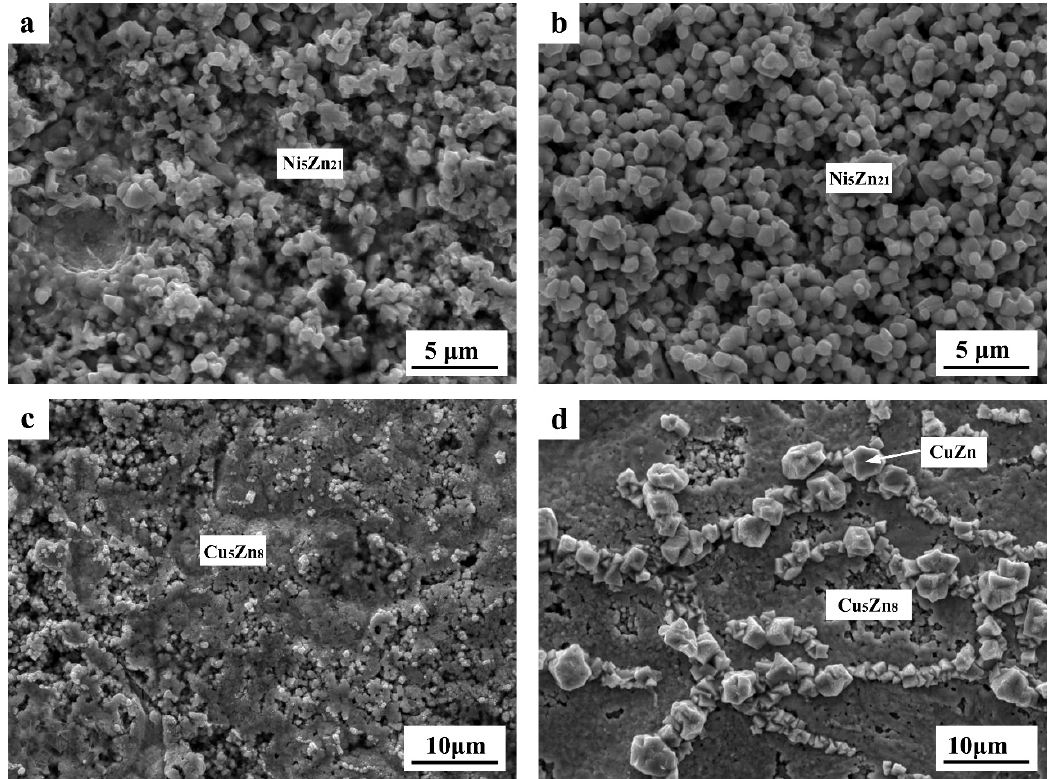
Figure 6. Etched surface micrograph of joints after soldered 9 h at 250 ◦ C: ( a ) Sn-Zn / Ni-20Cu; ( b ) Sn-Zn / Ni-40Cu; ( c ) Sn-Zn / Ni-60Cu; ( d ) Sn-Zn / Ni-80Cu.